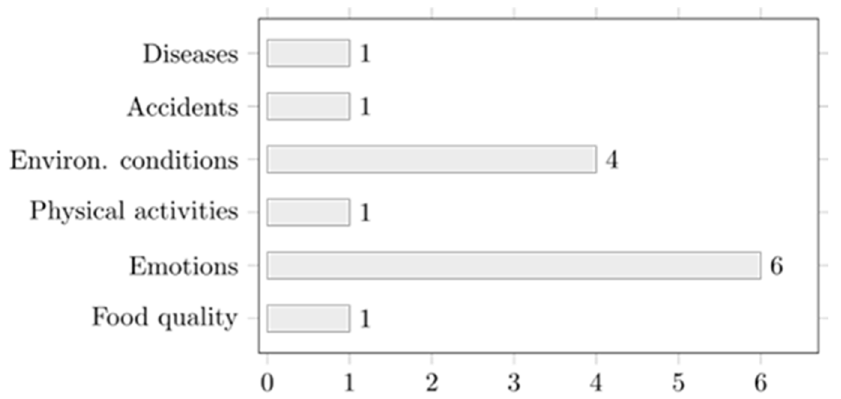
Figure 3. Number of articles found for each topic of the population surveillance domain.